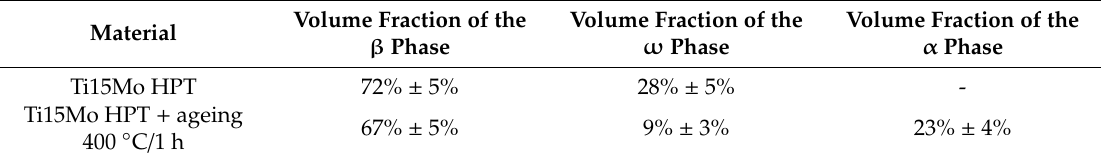
Table 2. Volume fraction of individual phases in HPT-deformed Ti15Mo alloy as determined from high energy synchrotron X-ray diffraction (HEXRD). The experimental errors are also shown.